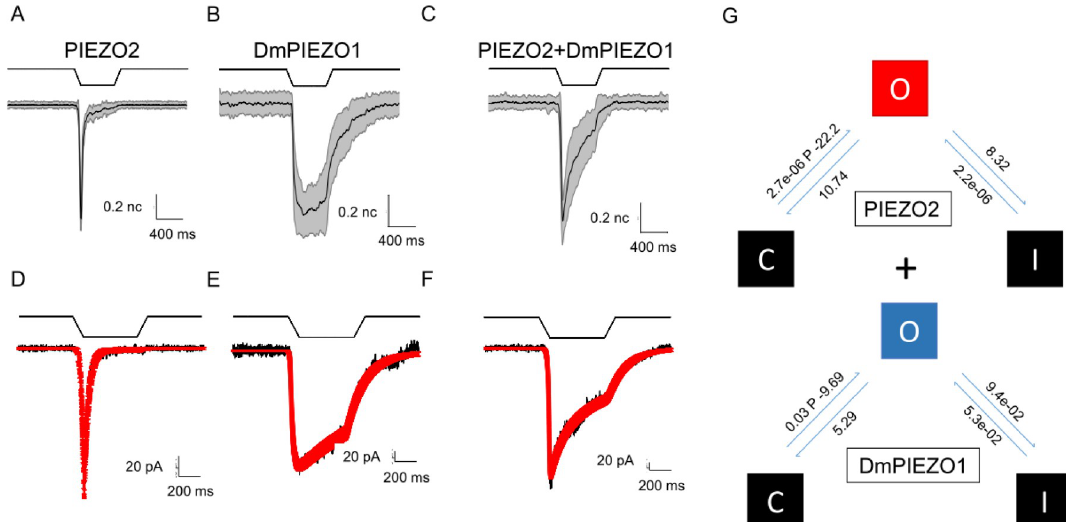
Fig 8. Kinetic analysis of current from hP1, hP2 cotransfections. Does coexpressing hP1 and hP2 lead to the formation of heteromers? To help differentiate between these two types of channels we used the double mutant form of PIEZO1 (PIEZO1-M2225R-R2456K), which has distinctly slower kinetics than wild-type channels. (A) and (B) show normalized and averaged traces for PIEZO2 and double-mutant PIEZO1, respectively. (C) shows normalized and averaged current from a cell expressing both channels. (D) Current from a PIEZO2-expressing cell superimposed with the fit generated by the model shown in the top part of (G) . (E) Current from a cell expressing the double-mutant form of PIEZO1 with a fit (red trace) superimposed; the model is displayed at the bottom of (G). (F) The current from a cell coexpressing both channels superimposed with a fit generated by summing the homomeric models for PIEZO2 and the double-mutant form of PIEZO1. This fit suggests that a simple sum of the homomeric models (G) can account for the observed kinetics and does not require heteromer